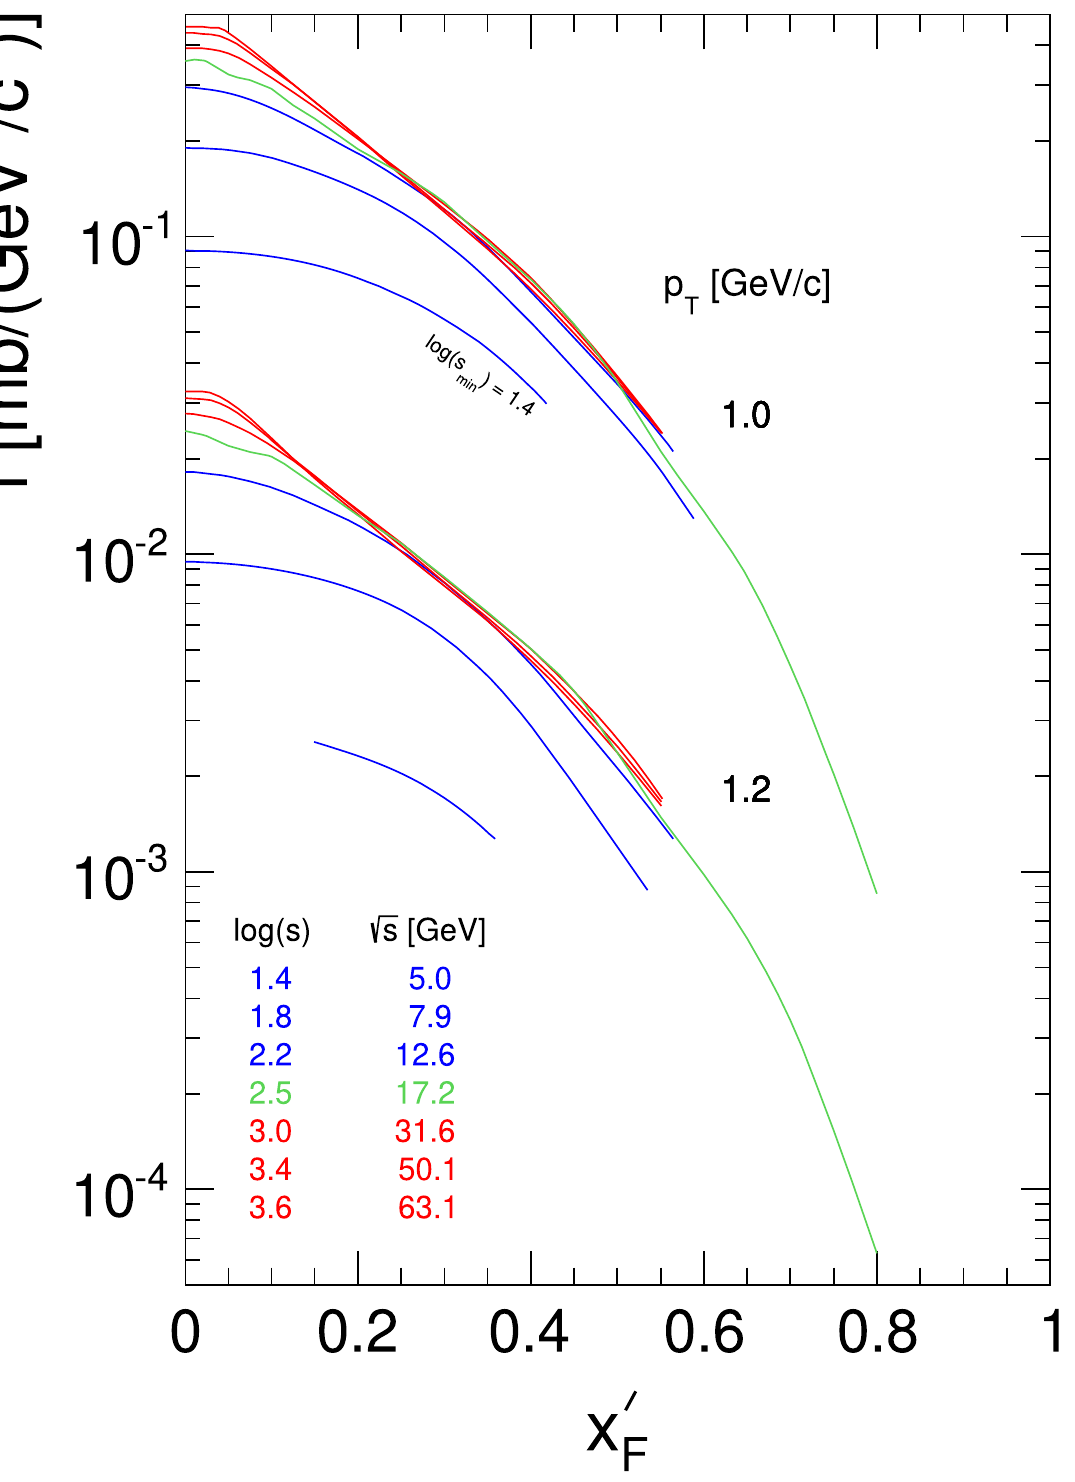
, p ) as a function of x (cid:3) Fig. 119 f ( x (cid:3) for p T = 1.0 and 1.2 GeV/c for the global interpolation at log ( s ) values from 1.0 to 3.6. The plots at T F F subsequent p T values are scaled down by 1/5 for better separation. The NA49 interpolation at log ( s ) = 2.48 is shown as a green